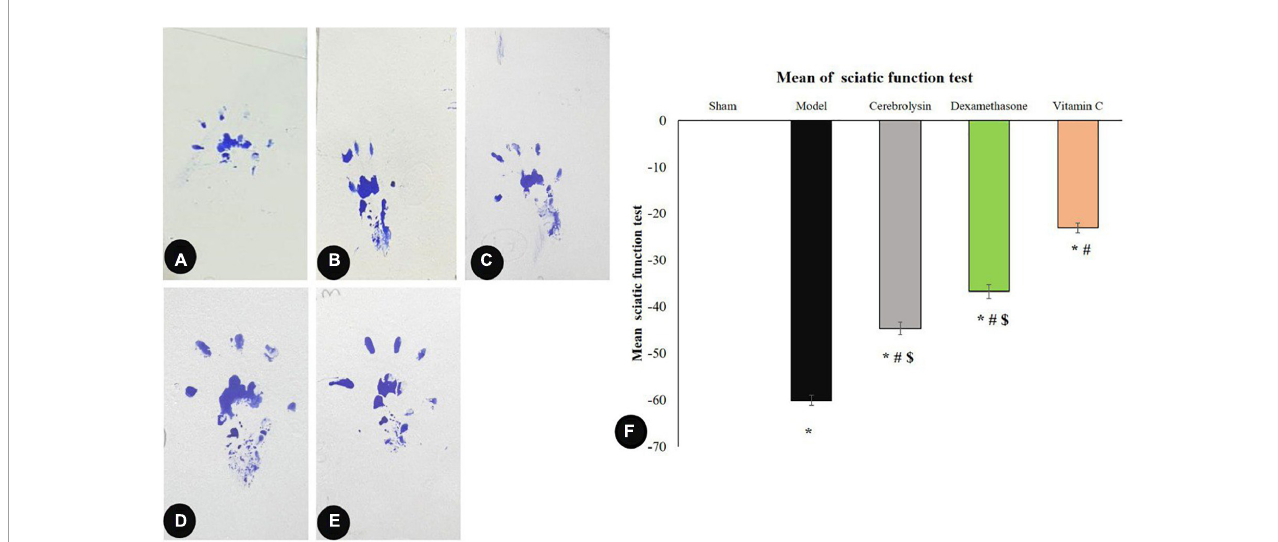
FIGURE2 Sciatic function index data: (A–E) representing rats’ footprints; sham (A) , injury (B) , Cerebrolysin (C) , dexamethasone (D) , and vitamin C (E) . (F) Histogram illustrating that after damage, the sciatic functional index (SFI) significantly decreased in comparison to the sham group. The SFI value was significantly higher in the vitamin C group versus the Cerebrolysin and dexamethasone groups. The difference between the Cerebrolysin and dexamethasone groups was not significant. *Significance as compared to control, # significance as compared to the model, and $ significance as compared to Vit C group.